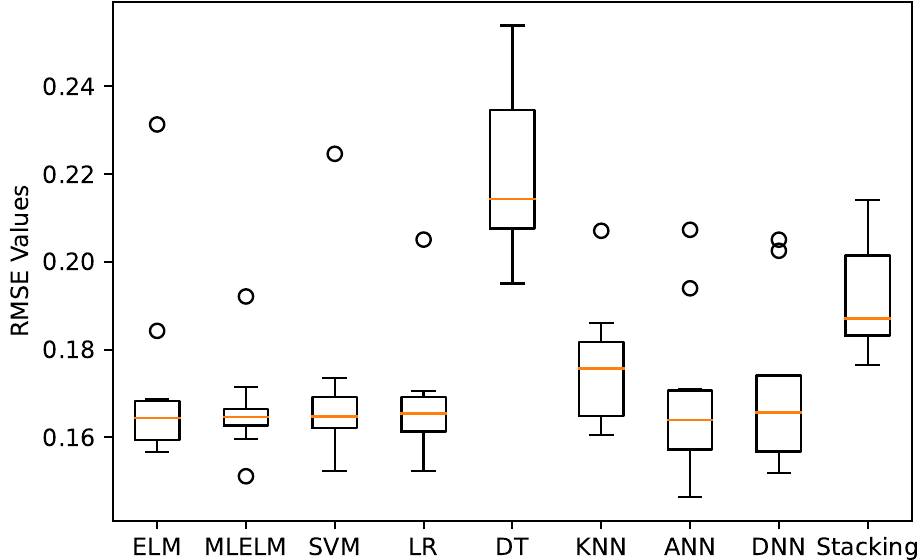
Figure 7. The performance of various models for annual building energy consumption: RMSE